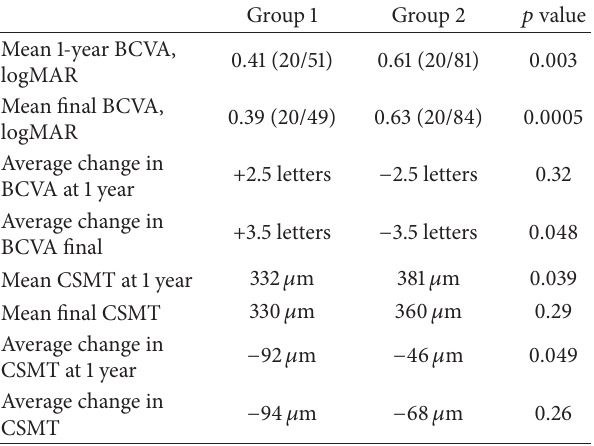
Table 2: Main outcome